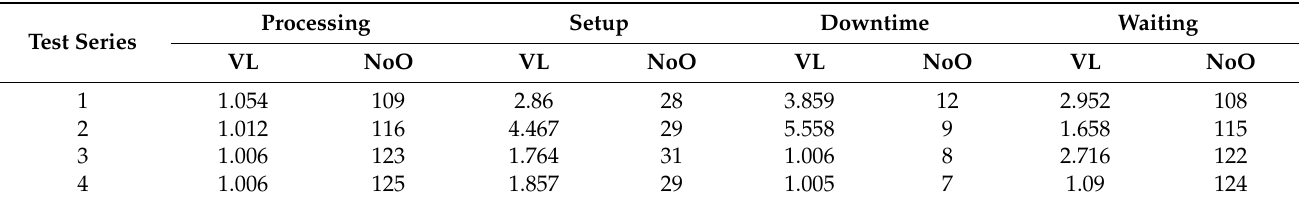
Table 1. Variability levels (VLs) and number of operations (NoO) of the states in the test series.